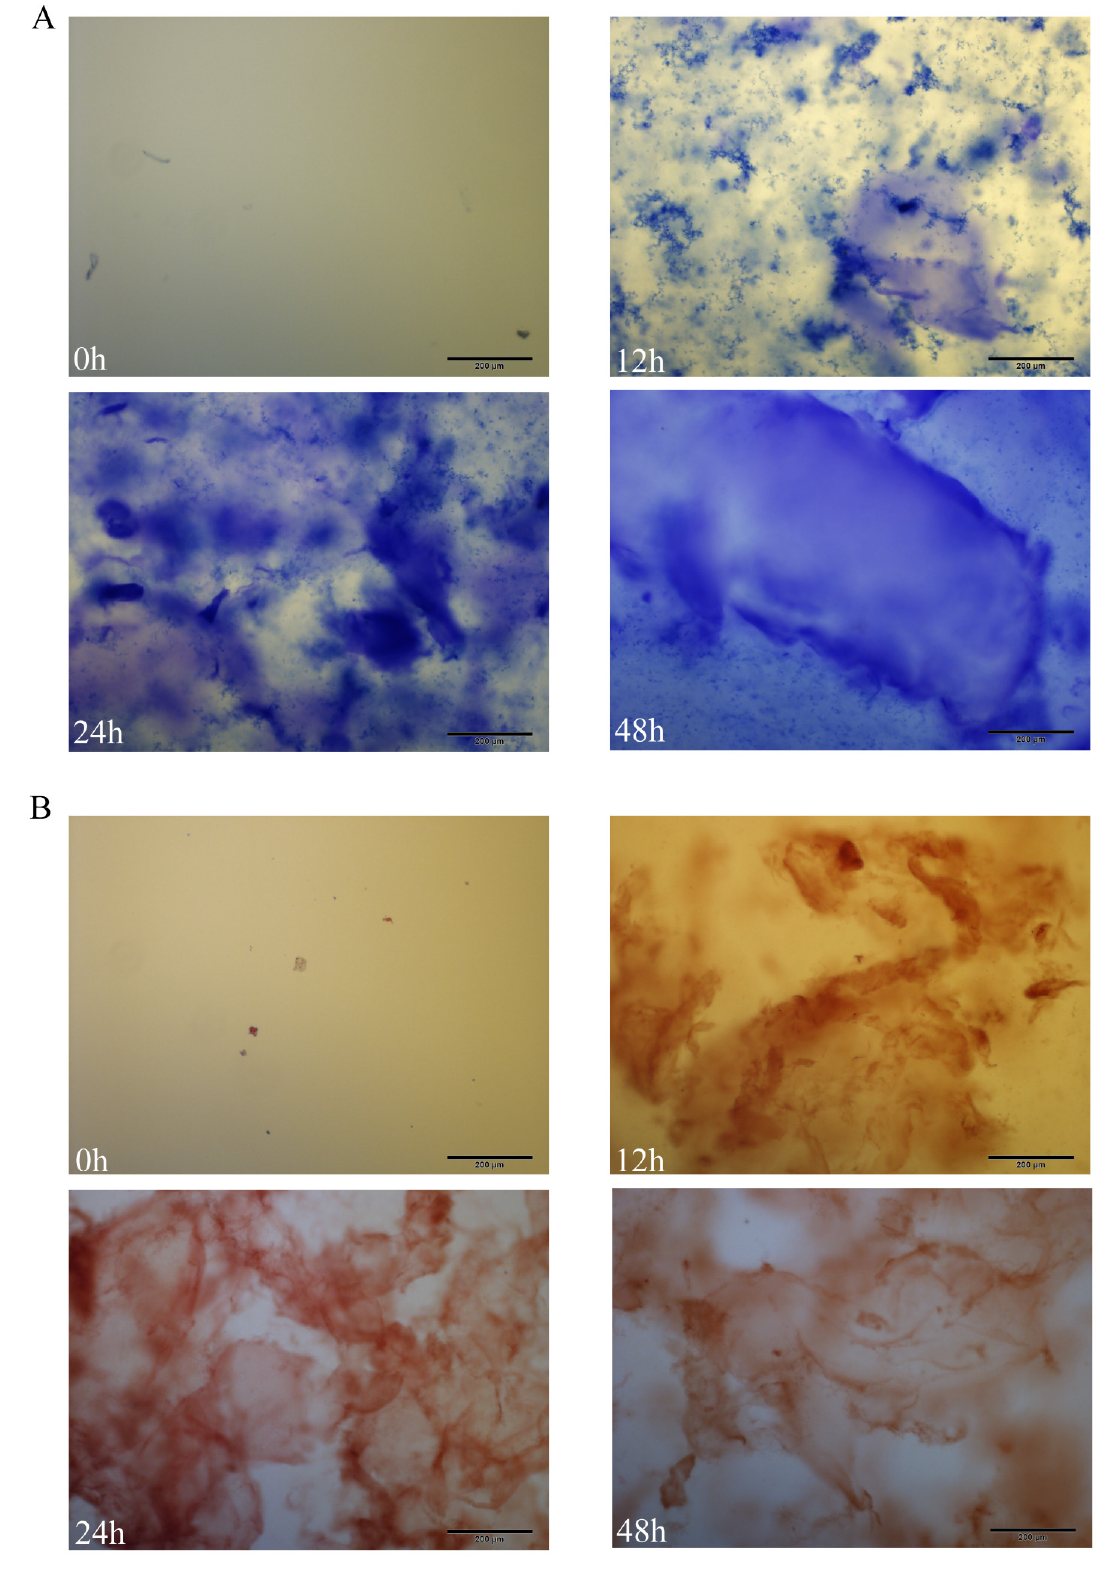
Figure 1. Congo red/aniline blue staining analysis. ( A ) Aniline blue staining results of DRF3 at 0, 12, 24 and 48 h; ( B ) Congo red staining results of DRF3 at 0, 12, 24 and 48 h.